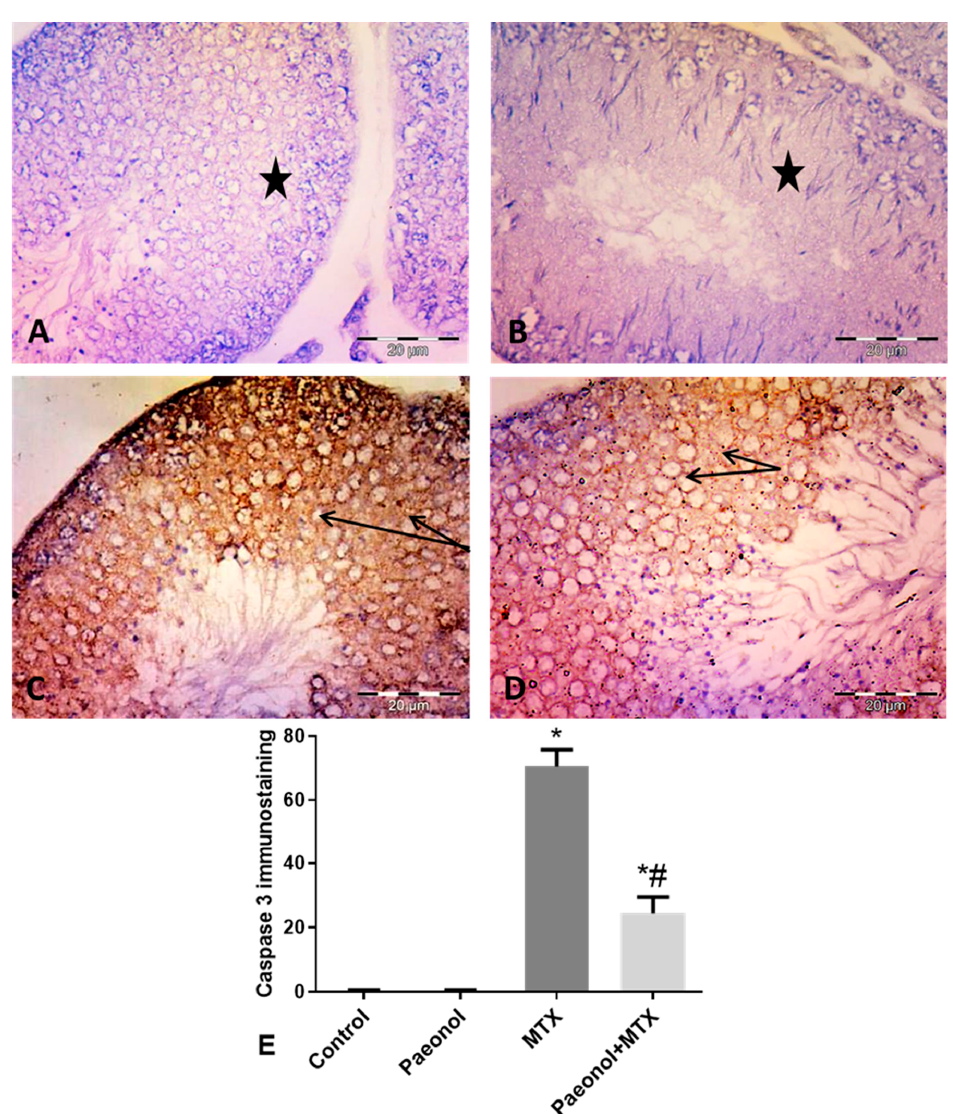
Figure 3. Immunohistochemical expression of testicular caspase 3 (×400). ( A and B ) Control and paeonol groups respectively, showing negative caspase 3 immunoreactivity (stars) in the germinal cells. ( C ) MTX group showing positive diffuse intense cytoplasmic caspase 3 immunoreactivity (arrows) in the germinal cells. ( D ) Paeonol + MTX group showing less cytoplasmic caspase 3 immunoreactivity (arrows) in germinal cells. ( E ) Mean area fraction of caspase 3 immunostaining. Results are mean ± SEM ( n = 8). * ,# Significantly different ( p < 0.05) from control and MTX groups, respectively. MTX: methotrexate.